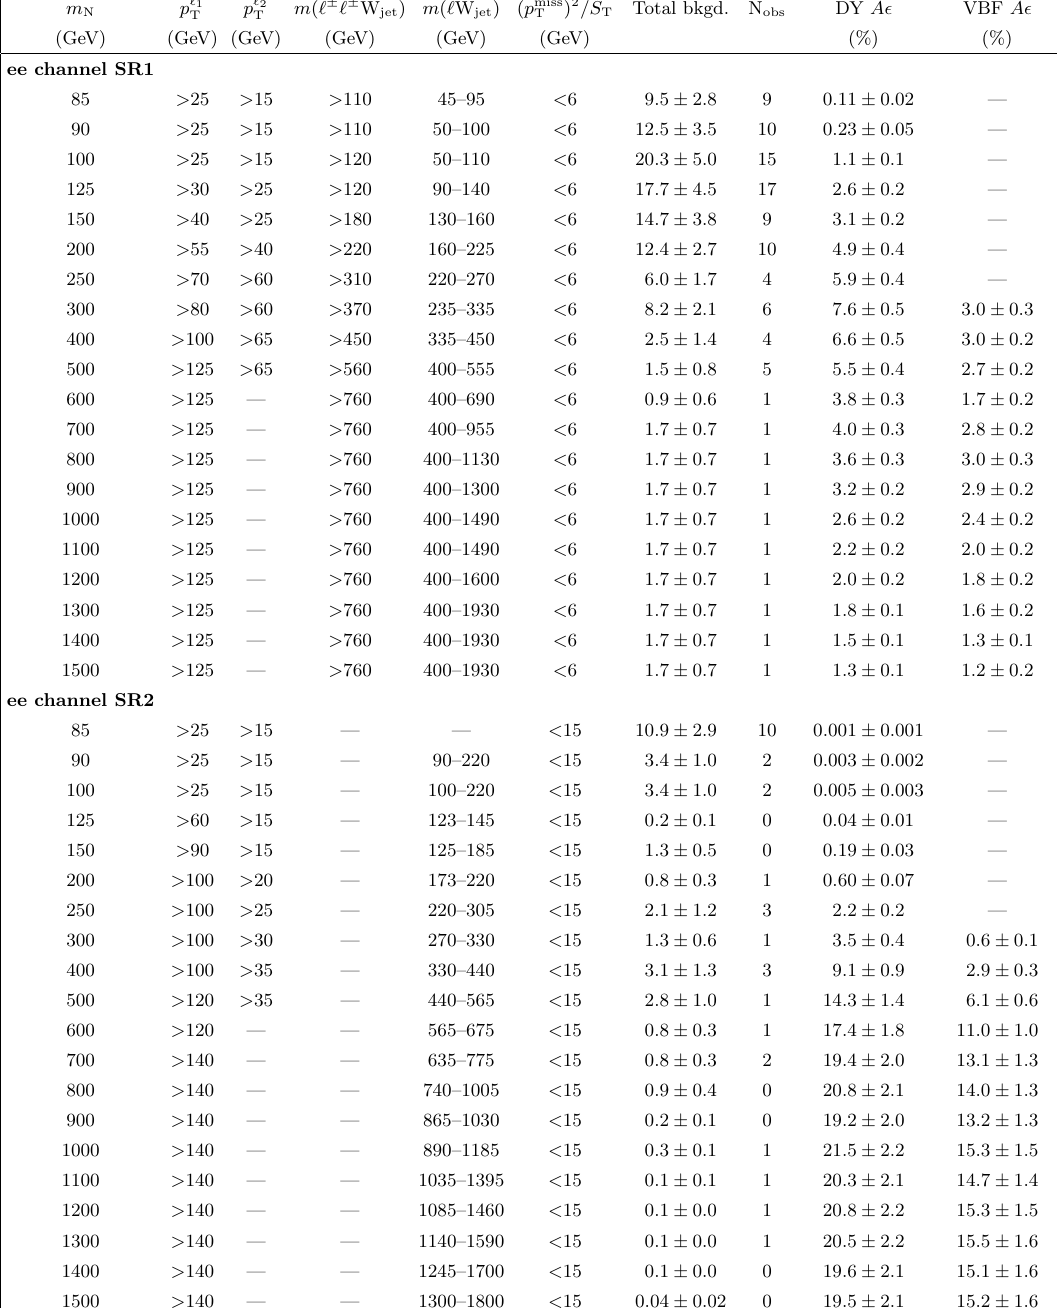
Table 8 . Selection requirements on discriminating variables determined by the optimization for each Majorana neutrino mass point in the ee channel high-mass SRs. Columns 7 and 8 show the total background yields (Total bkgd.) and the number of observed data (N obs ), respectively. The last columns show the overall signal acceptance for the DY and VBF channels. The quoted uncertainties include both the statistical and systematic contributions. The dash indicates that no selection requirement is made.